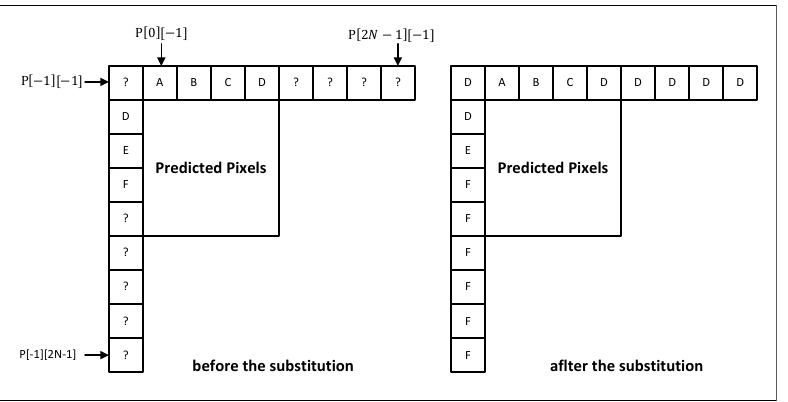
Figure 3. Illustration of sample substitution process for prediction block 4 ×